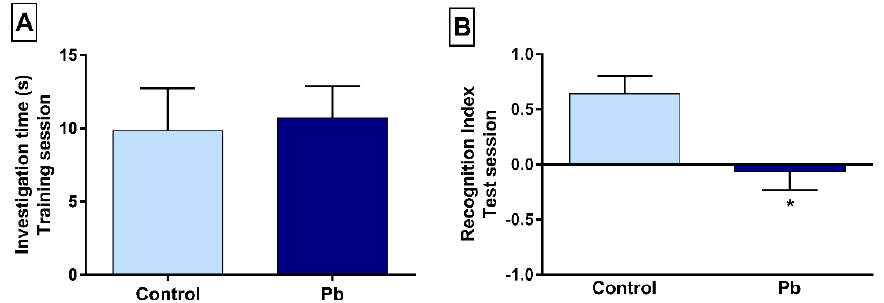
Figure 1. E ff ects of long-term exposure to Pb on short-term memory, evaluated by object recognition test. ( A ) Columns represent the total investigation time of object C1 plus the investigation time of object C2 (C1 + C2), counted in seconds; ( B ) the recognition index was calculated by the time the animals investigated the new and familiar objects (T - C3 / T + C3) during the test phase, performed 30 min after the training. The results are expressed in mean ± S.E.M of the investigation time in the training phase and recognition index in the test phase, for 3 min. * p < 0.05 compared to the control group (Student’s t-test).